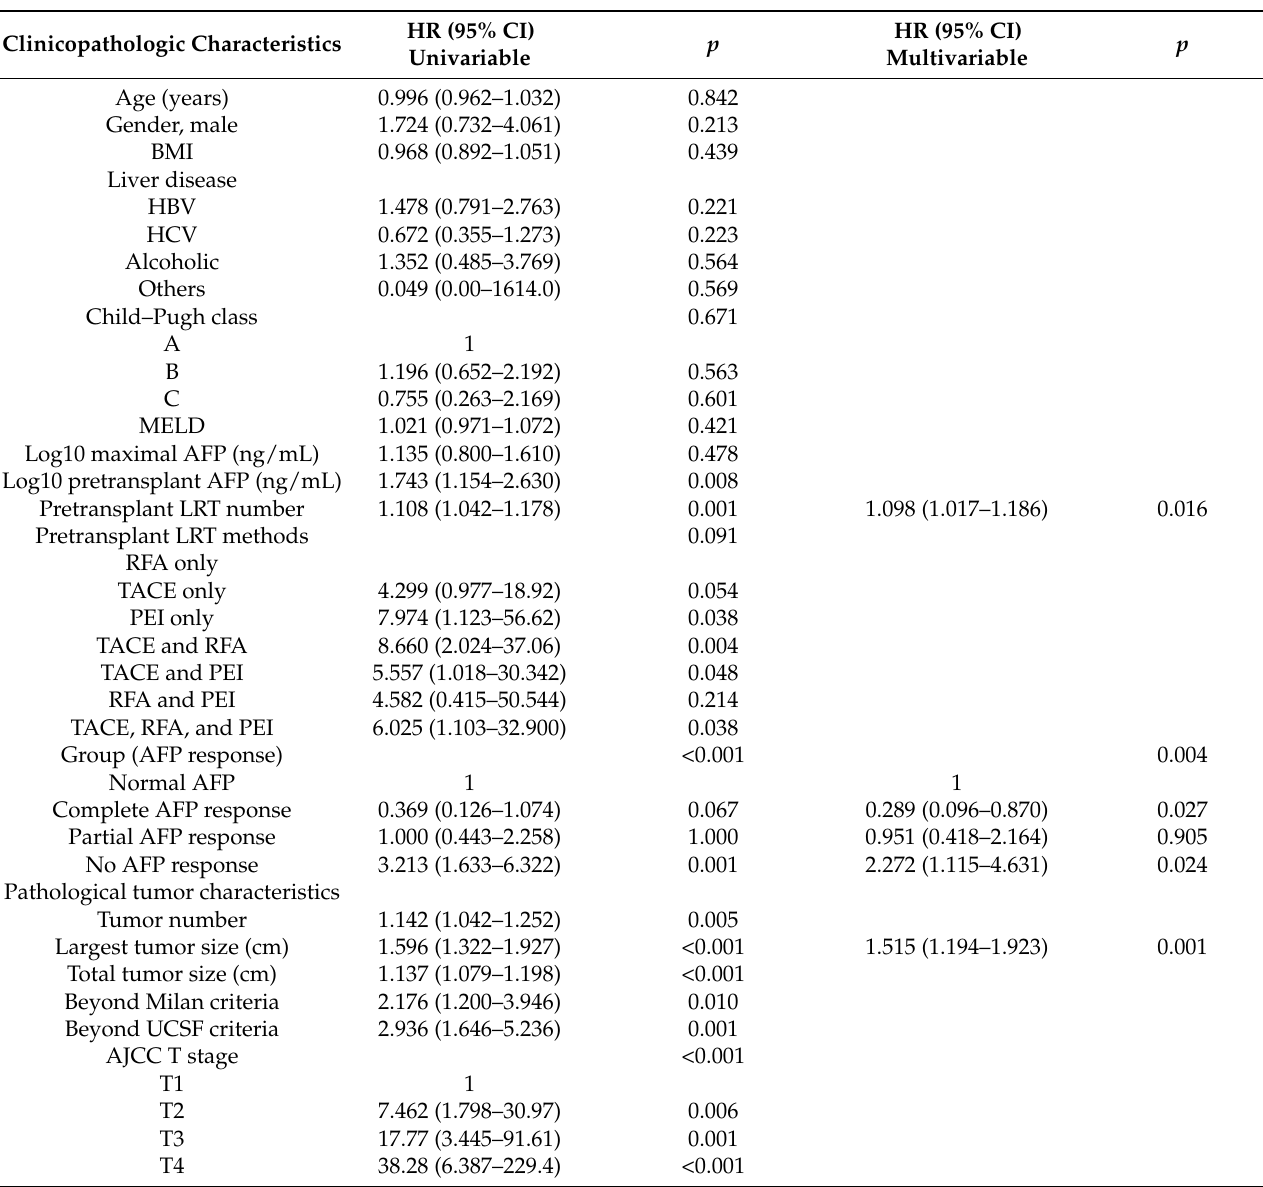
Table 3. Cox hazard analysis (univariable and multivariable) of clinicopathologic data for tumor recurrence with locoregional therapy.